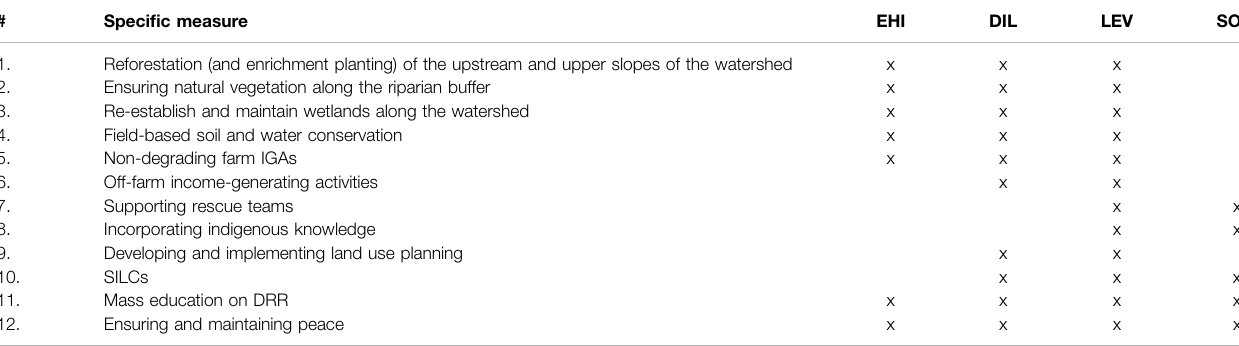
TABLE 2 | Sample key measures linked with the views from the participants regarding key criteria for prioritization. # EHI